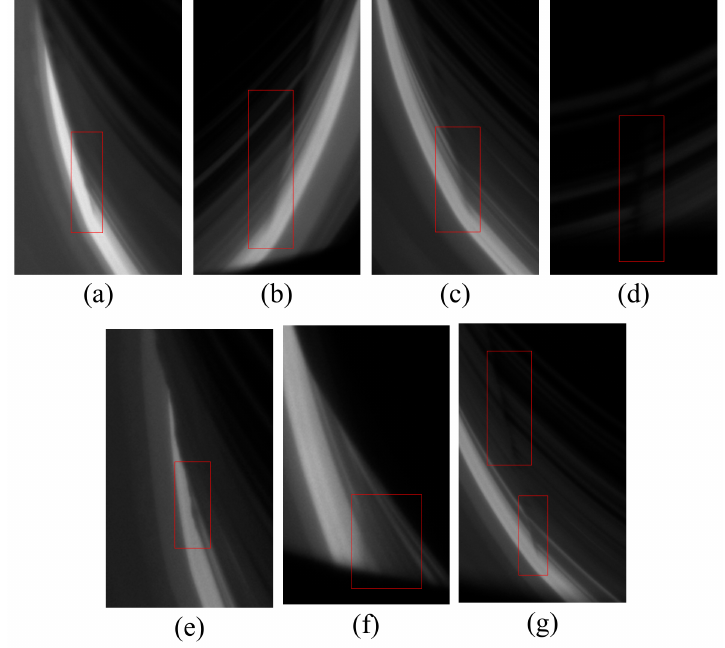
Figure 4. ( a – g ) Di ff erent patterns of normal habit lines.